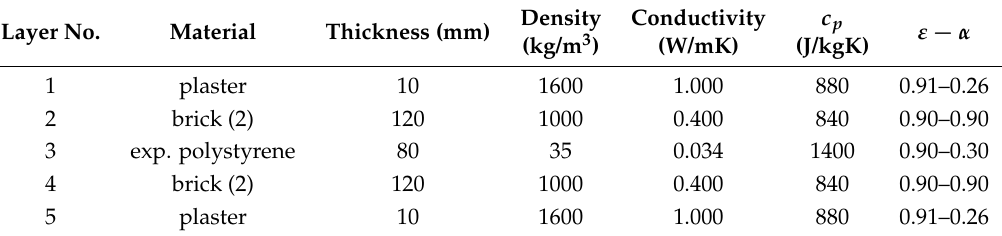
Table A2. Case B: sandwich wall, “PTS” (Layer 1 is outdoors). Thickness: 340 mm. Layer No.